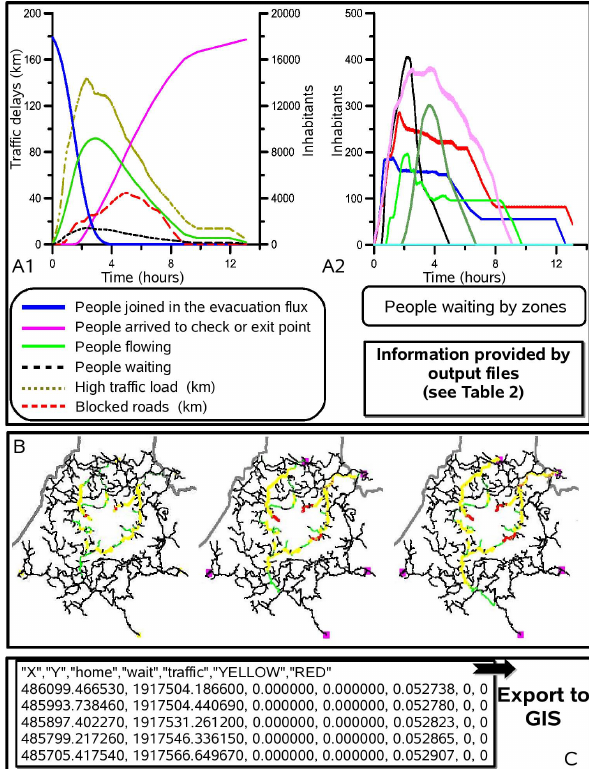
Fig. 9. (A) VSEM evacuation process diagram. The CELL() func- tion is the most important in the evacuation model. In each itera- tion, for all p road objects, the CELL() function: 1) computes how many people moves from one status to other (from home to wait- ing, from waiting to flowing), 2) determines the flux velocity, 3) fixes the number of step (iterations) needed to cover the distance between two p road objects, 4) estimates the fraction of people that will be transferred from one p road object to the other and stores in a temporal variable (limbo). The people displacement is controlled by the UPDATE() function, which 1) analyses the flag status and transfers people if the level of occupancy of the p road object is less than the total limit of its capacity (see text for more details) and 2) stores, every few iterations, the obtained data in the output files. (B) Sketch of the transfer process (see text for more details).